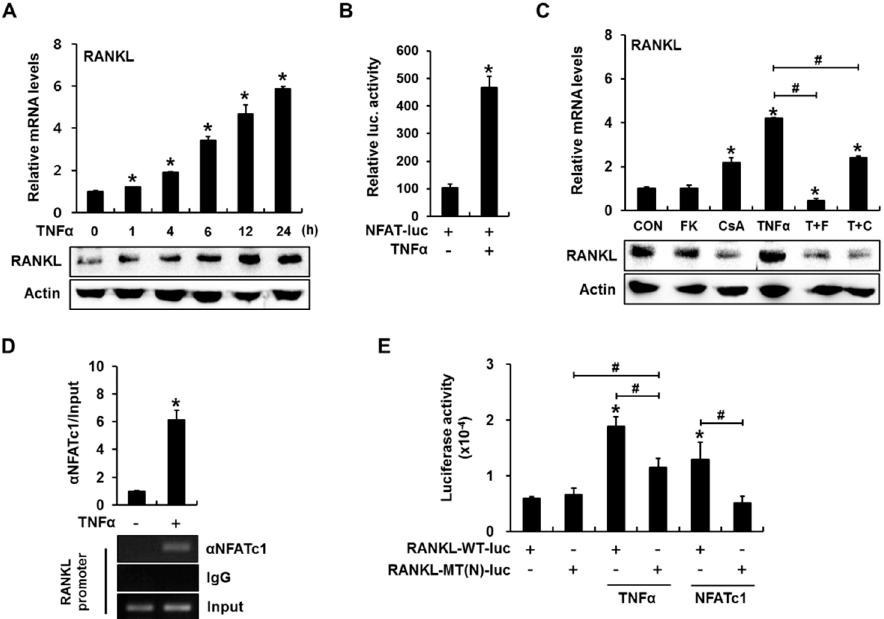
Figure 1. Calcineurin/nuclear factor of activated T-cells (NFAT) activation is involved in tumor necrosis factor α (TNF α )-induced receptor activator of nuclear factor- κ B ligand ( RANKL ) expression in C2C12 cells. ( A ) TNF α increased RANKL expression in a time-dependent manner. C2C12 cells were incubated in the presence of 10 ng/mL TNF α for the indicated time periods and subjected to quantitative reverse transcription-polymerase chain reaction (RT-PCR) and western blot analyses. Quantitative data are presented as means ± standard deviations (SD); ( B ) TNF α induces NFAT transcriptional activity. C2C12 cells were transfected with a reporter plasmid containing an NFAT response element, exposed to TNF α for 24 h, and subjected to a luciferase assay. Data are presented as firefly luciferase activity levels relative to Renilla activity; ( C ) Inhibition of the calcineurin/NFAT pathway blocked TNF α -mediated RANKL expression. C2C12 cells pretreated with FK506 (10 µ g/mL) or cyclosporin A (10 µ g/mL) were treated with TNF α for 24 h and subjected to RT-PCR and western blot analyses; ( D ) TNF α increases NFAT binding to the mouse RANKL promoter. C2C12 cells were incubated for 24 h with TNF α , after which a chromatin immunoprecipitation (ChIP) assay was performed using an antibody against NFATc1, with IgG serving as a negative control. The RANKL promoter region containing the NFAT binding element was amplified via PCR. Quantitative ChIP data were normalized to the input and are presented as values relative to vehicle-treated control samples (CON) ( E ) TNF α increased RANKL promoter–reporter activity in an NFAT binding element-dependent manner. C2C12 cells were transfected with a wild-type ( RANKL -WT-luc) or NFAT-binding site mutant ( RANKL -MT(N)-luc) RANKL promoter reporter, incubated for 24 h in the presence of TNF α or NFAT overexpression vector, and subjected to a luciferase assay (* p < 0.05, compared to control; # p < 0.05, compared to the indicated pair).